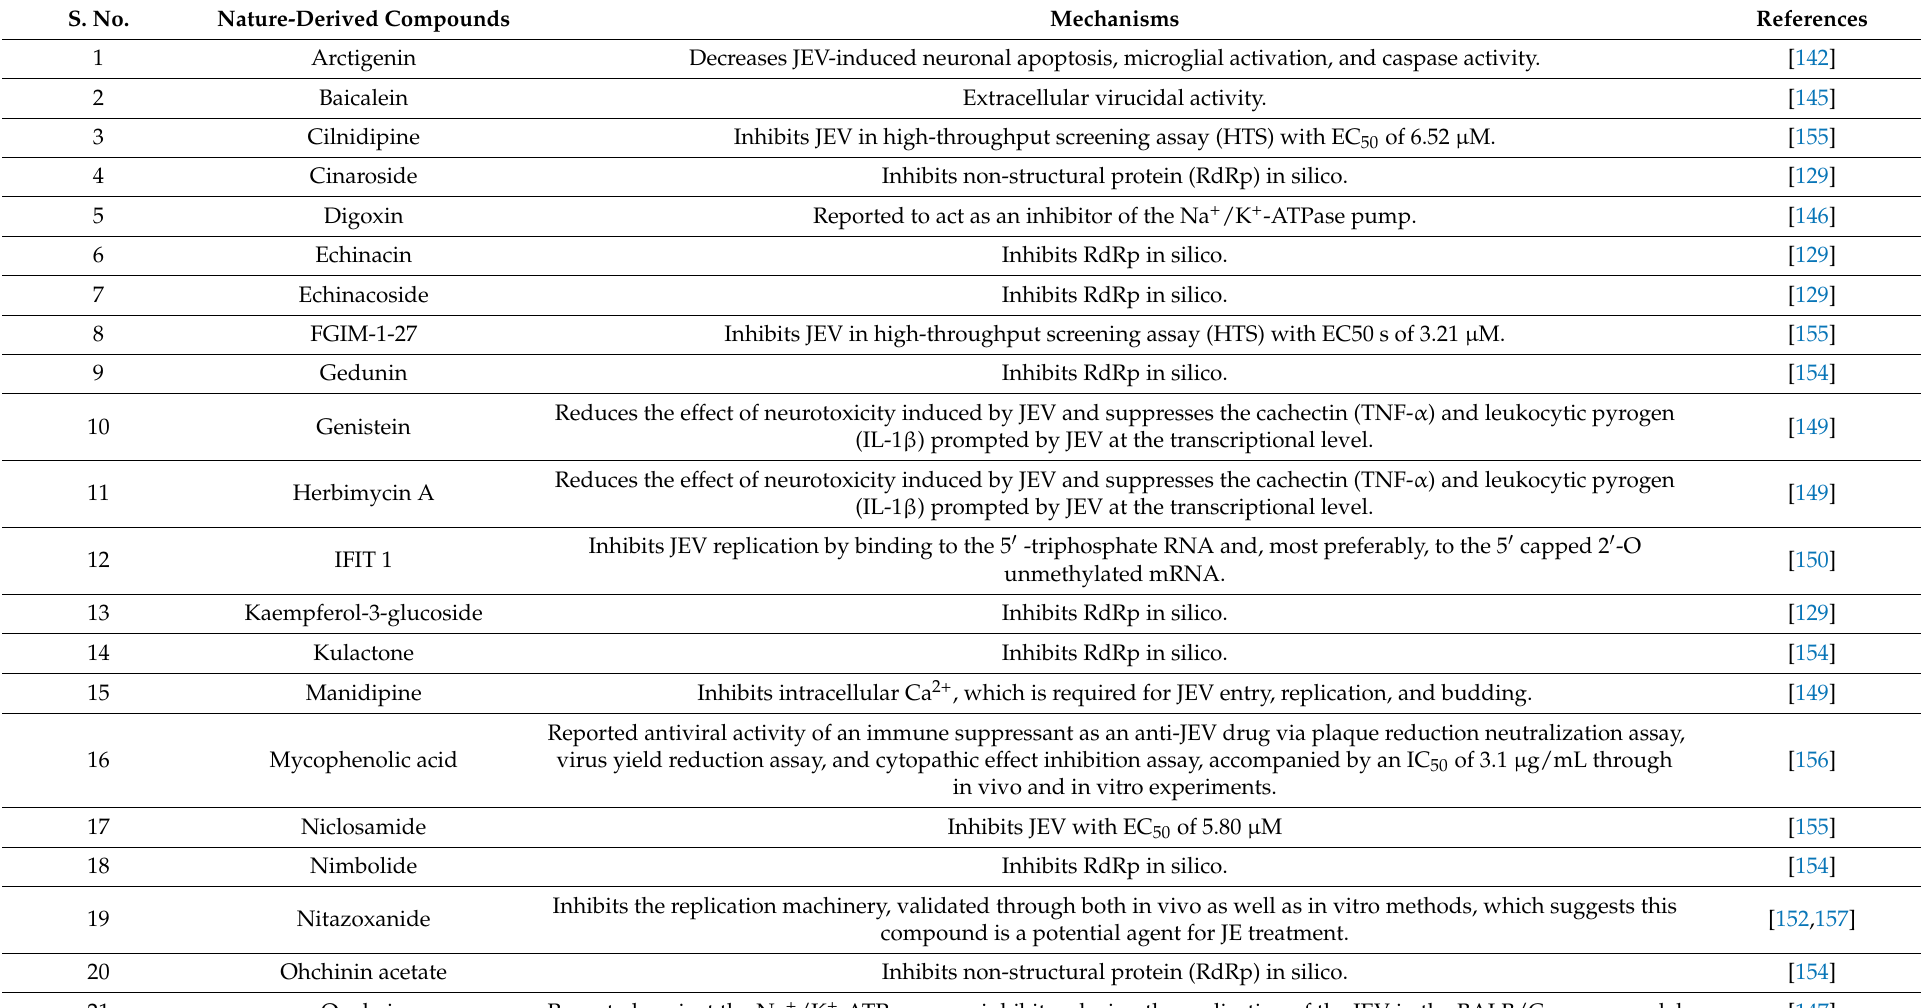
Table 4. Preclinically validated molecules inhibiting JEV